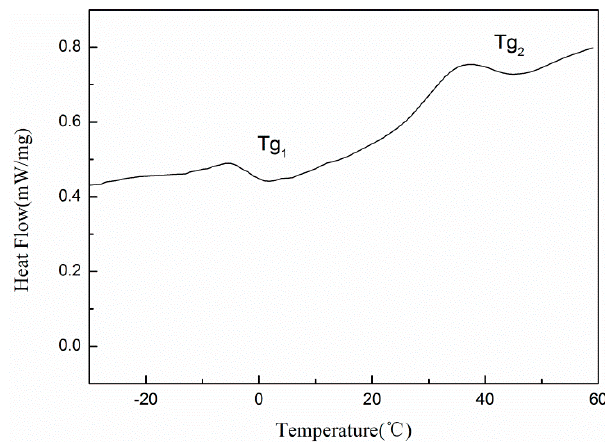
Figure 6. DSC curve of the latex film with 4% DNS-86.